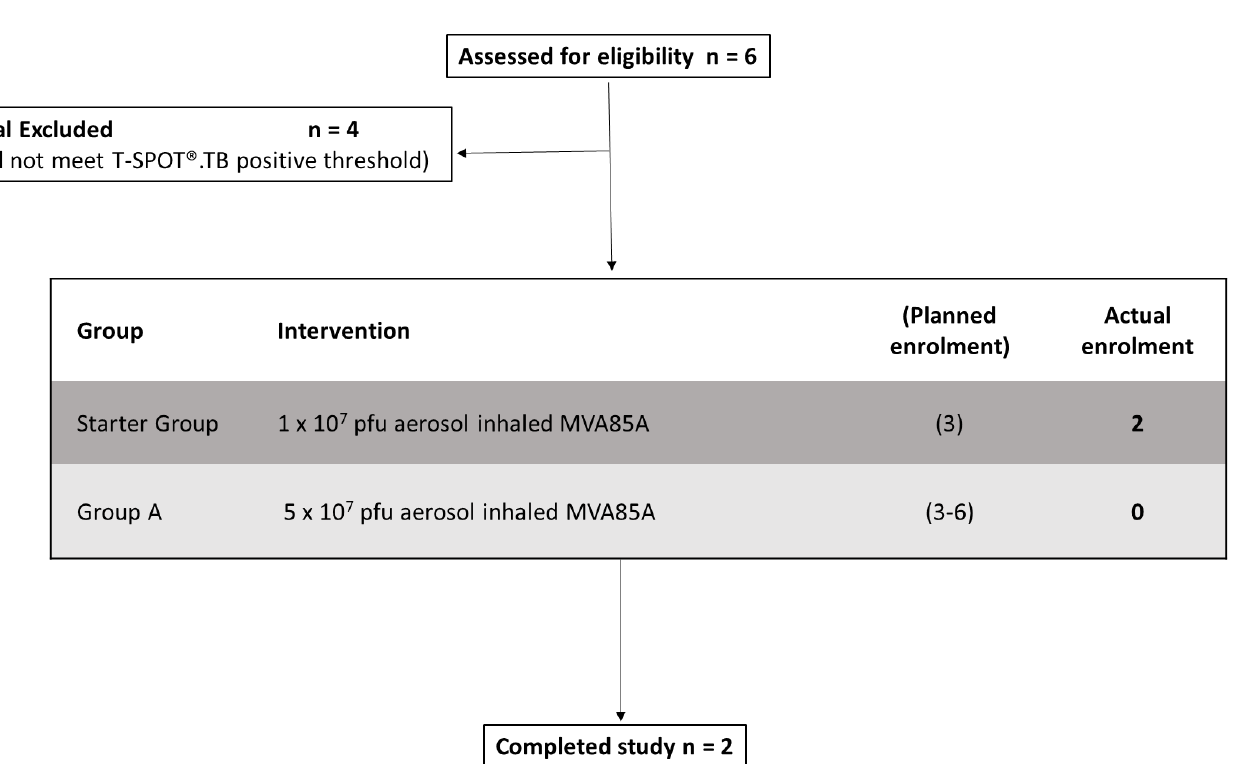
Figure 1. CONSORT flow diagram showing subject recruitment, follow-up, and reasons for exclusion.